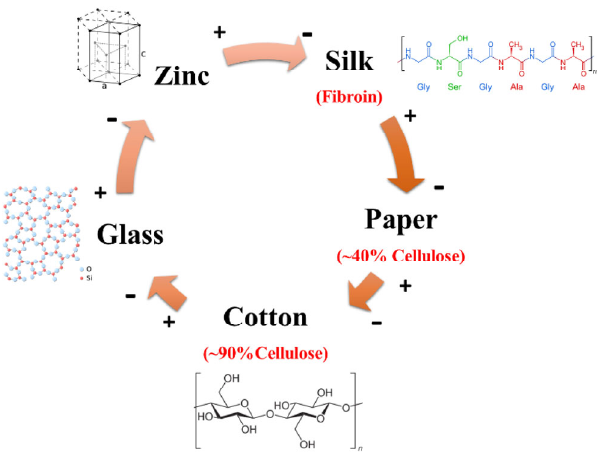
Fig. 7 Demonstration of cyclic triboelectric